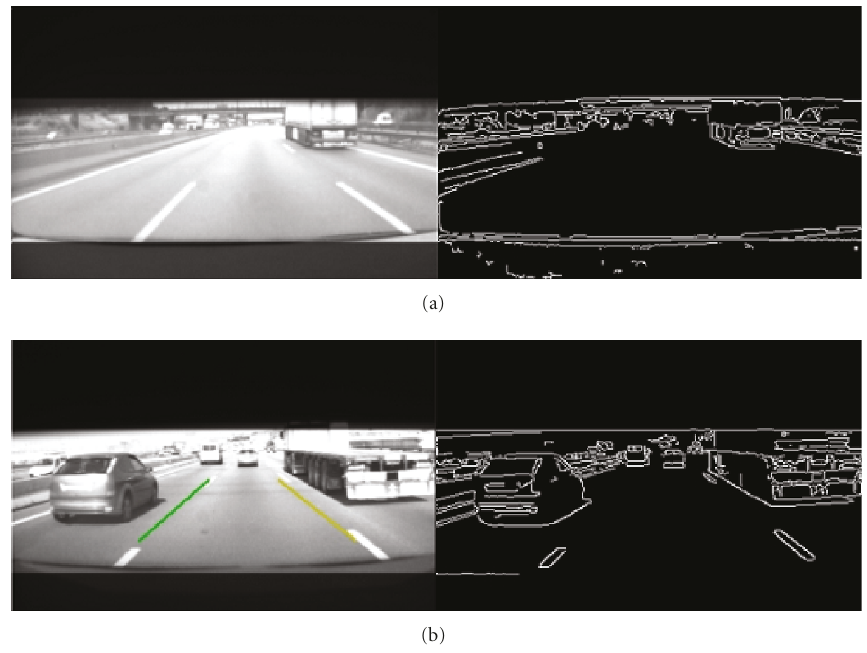
Figure 9: Canny images after adaptive